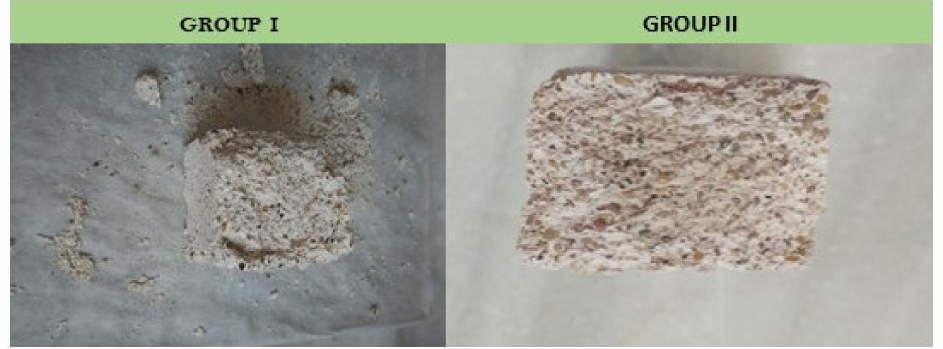
Figure 11. View of the fracture of representative specimens of Group Ia and IIa after 21 days in environmental chamber.